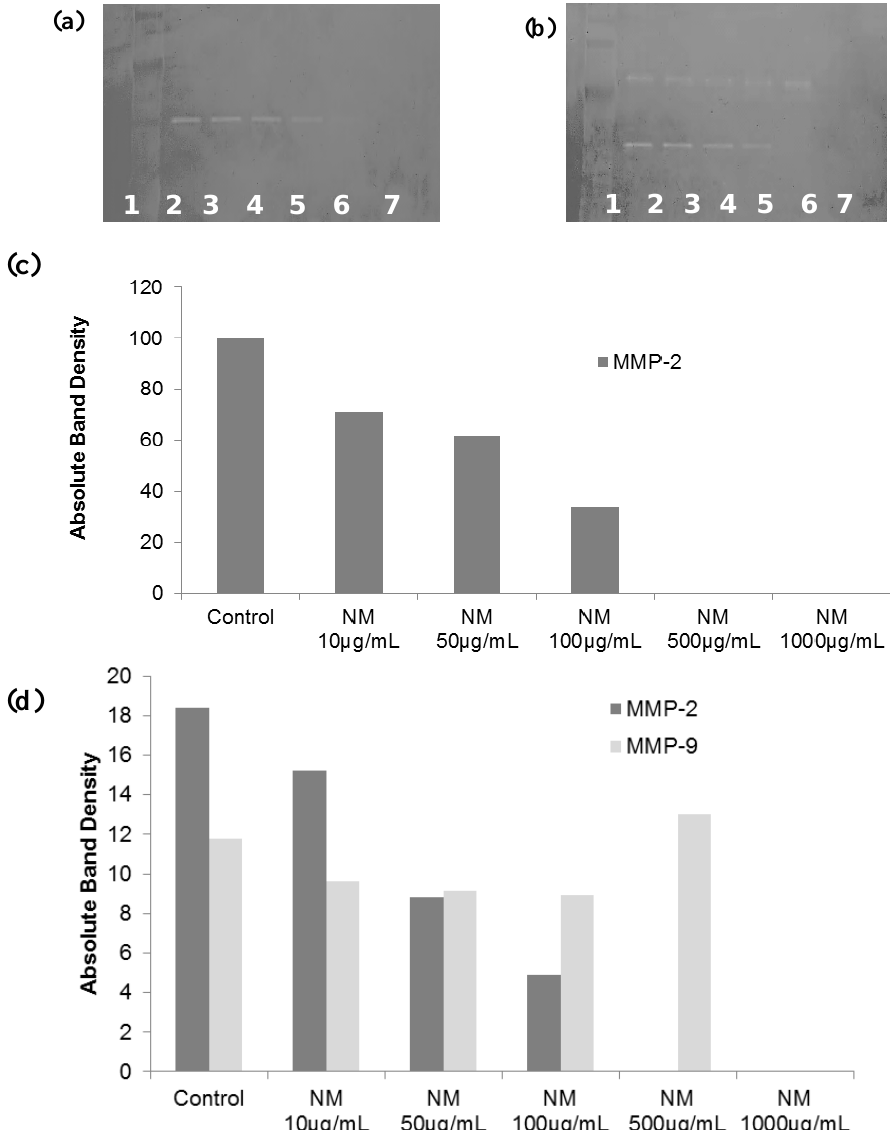
Figure 3. Effect of NM on HepG2 MMP secretion ( a ) Normal HepG2 MMP